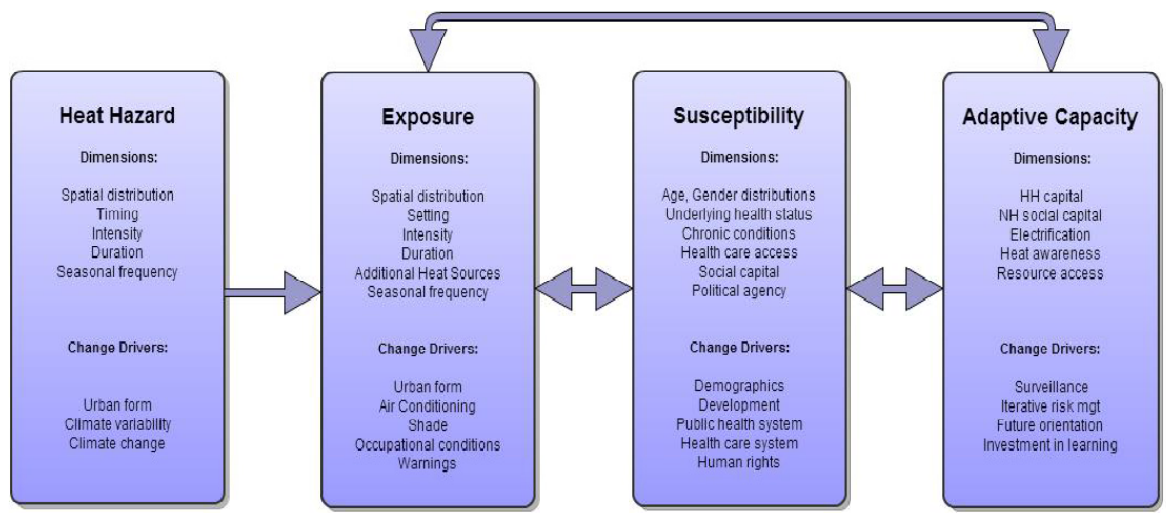
Figure 1. Framework for assessing heat vulnerability: hazard probability, population exposure, susceptibility factors, and adaptive